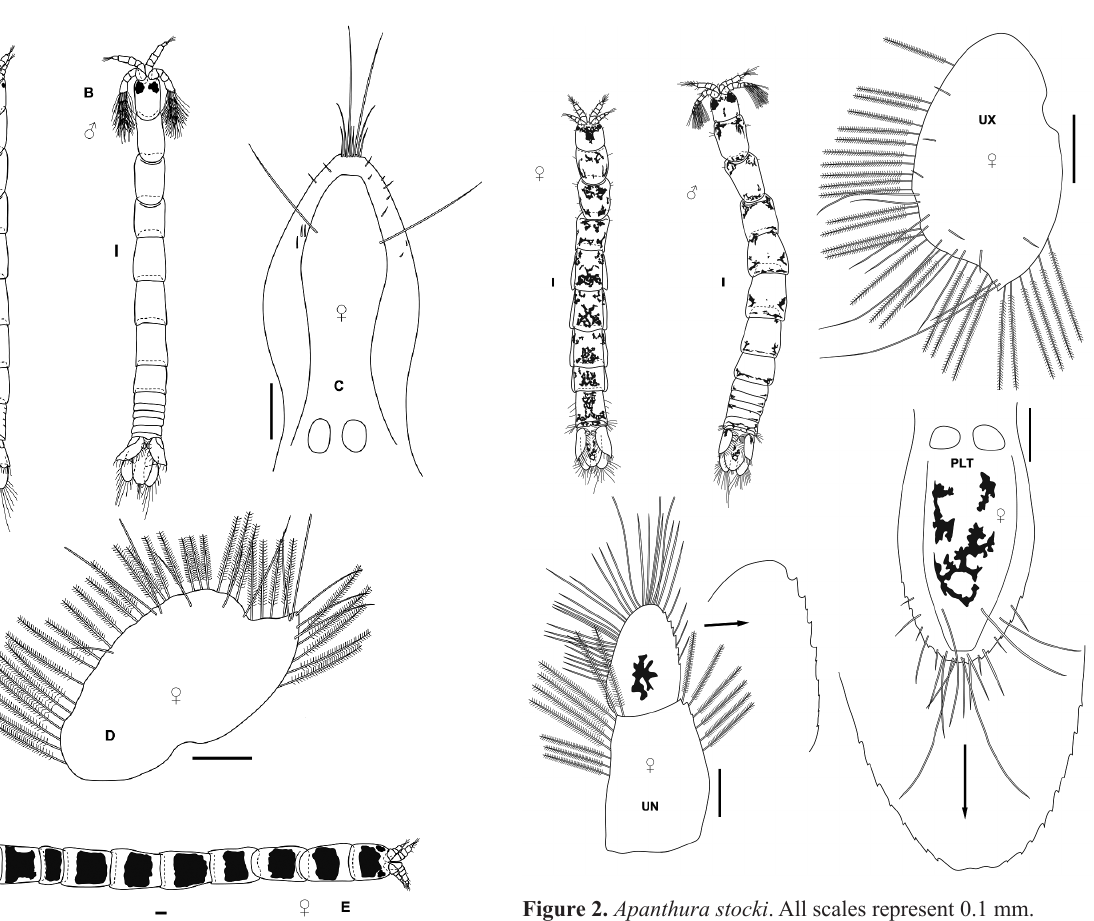
Figure 2. Apanthura stocki . All scales represent 0.1